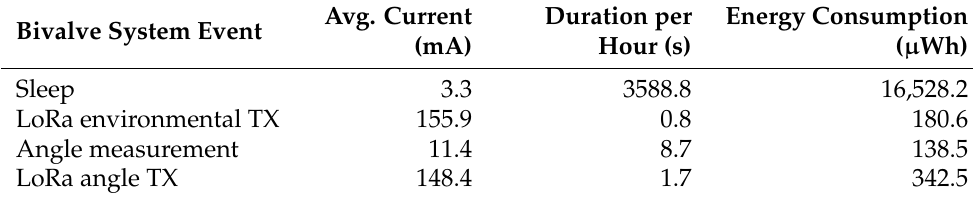
Table 5. Bivalve system events power consumption